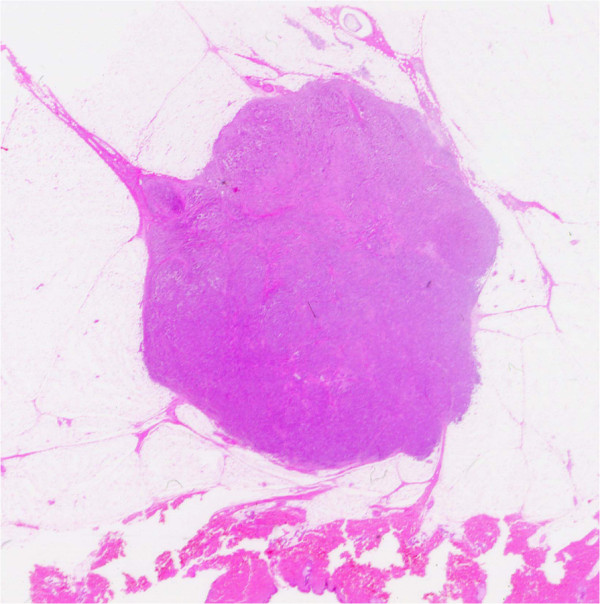
Representative histopathological specimens of the three subtypes of invasive ductal carcinoma–not otherwise specified. Solid tubular growing type (Solid-tub) consists of a solid cluster of cancer cells with expansive growths that form relatively sharp borders
[4].